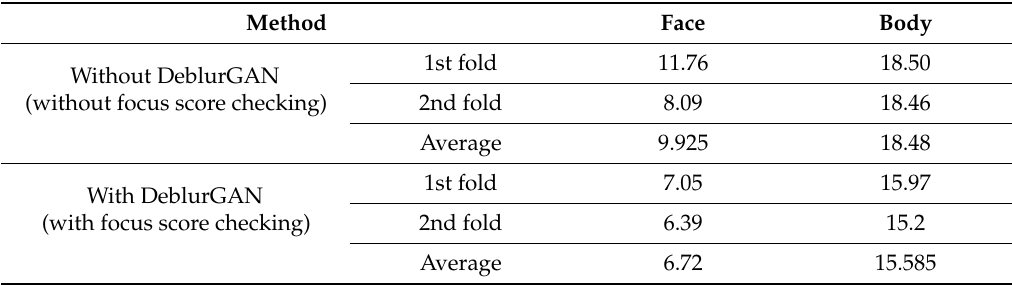
Table 10. Comparison of EER for face recognition and body recognition on ChokePoint dataset without or with DeblurGAN (unit: Table 11. Comparison of EER for score-level fusion on ChokePoint dataset without or with DeblurGAN (unit: %).